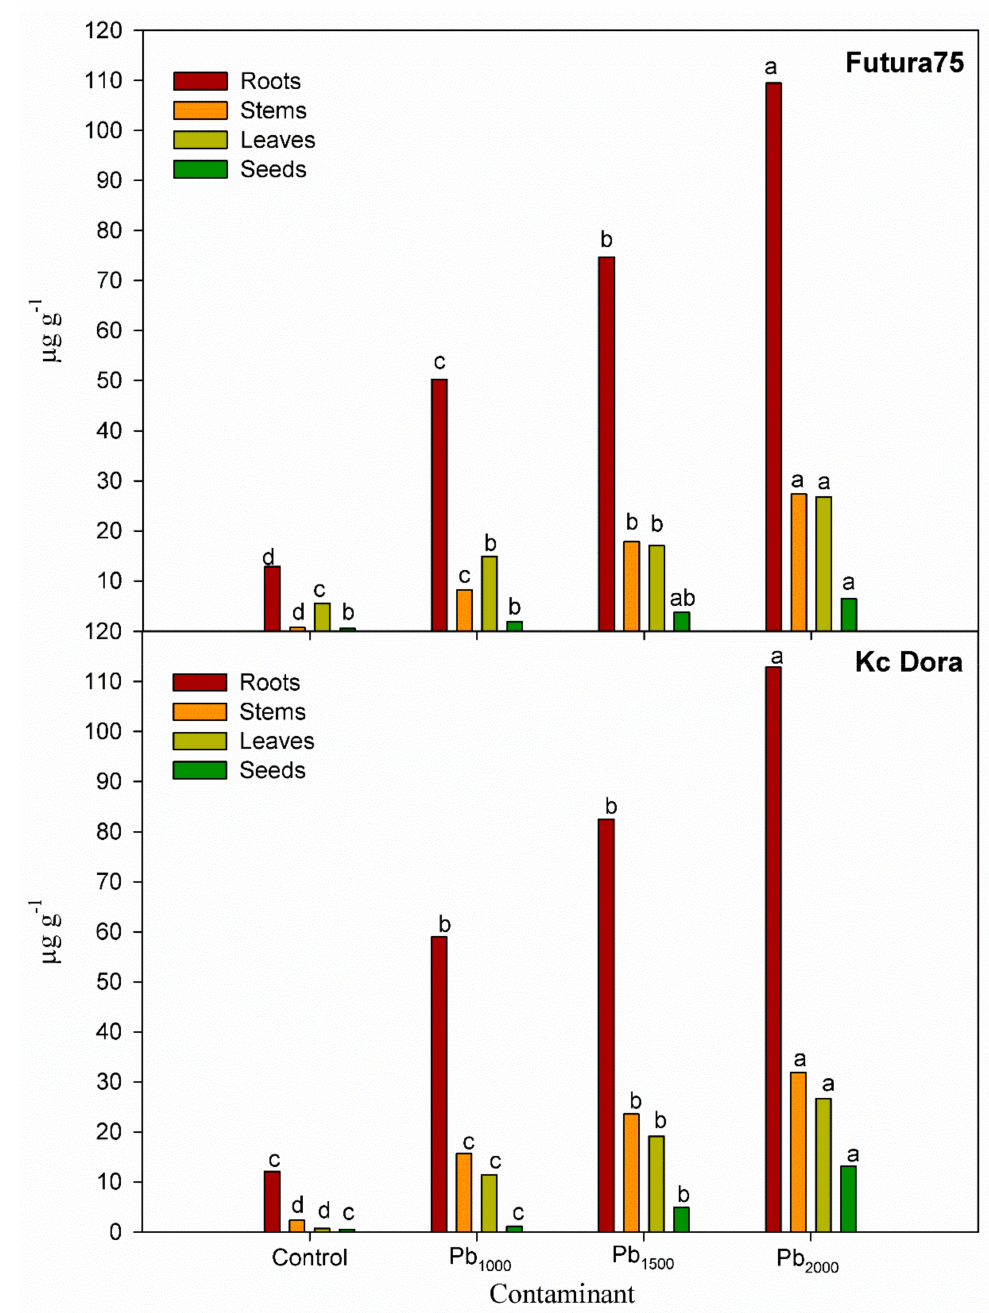
Figure 4. Concentration of lead ( µ g g − 1 ) in roots, stems, leaves, and seeds in Futura 75 and KC Dora. The comparisons were performed within the fractions of the plant. Different letters indicate significant differences between the means (according to HSD at p ≤